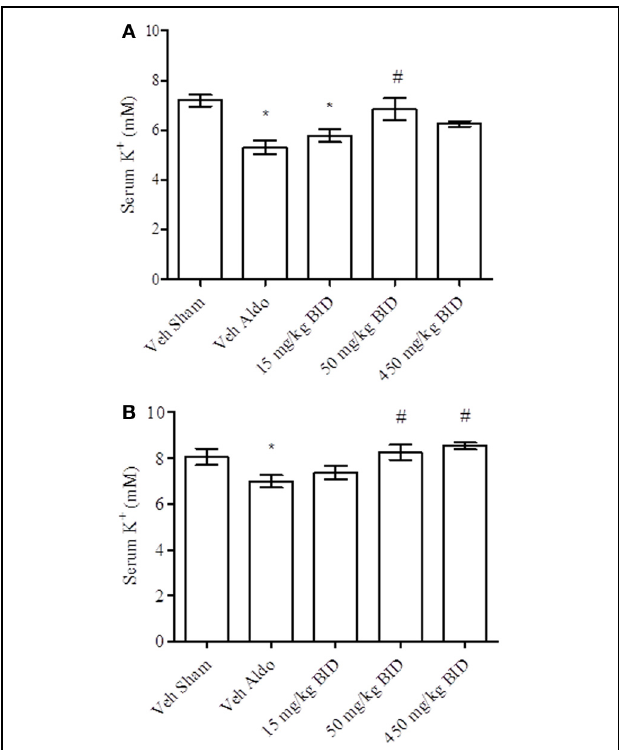
FIGURE 3 | Effect of eplerenone on serum K + on day 14 (A) and day 26 (B). Data are represented as mean ± standard error of the mean. See Materials and Methods for statistical analysis. ∗ Indicates a significant difference from the vehicle sham (Veh Sham) group; # Indicates a significant difference from the vehicle + aldosterone (Veh Aldo)